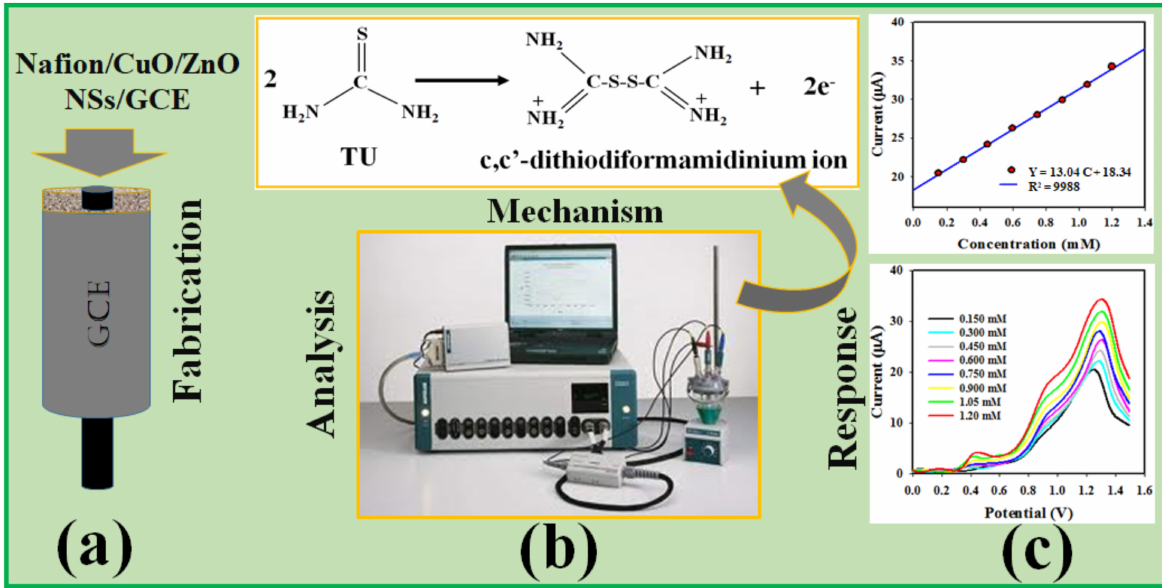
Scheme 1. Schematic representation of electrochemical analyses in the detection of TU. ( a ) Modification of GCE with CuO/ZnO NSs. ( b ) Instrumentation of assembled sensor probe to perform the differential pulse voltammeric analysis of TU to c,c’–dithiodiformamidinium. ( c ) The recorded analysis data.